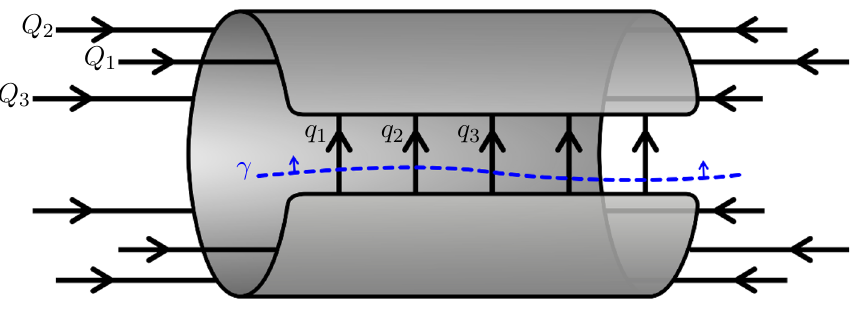
Figure 7 . A planar diagram with cylinder topology, cut open into a disk along a set of internal propagators. The non-trivial e(cid:11)ect of the (cid:3) -deformation of the diagram (3.2) localises on the propagators crossing the